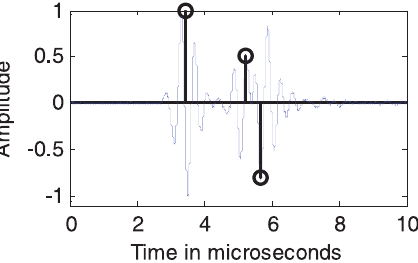
Fig. 5. (a) Two closely spaced overlapping echoes with a SNR of 8 dB. (b) Deconvolution echoes for (a).